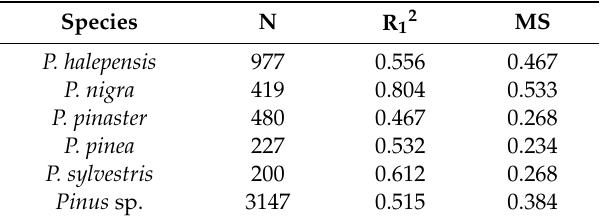
Figure 4. Mean values of NDII-defoliation index synchronization for all Pinus species studied ( left ) and for five Pinus species ( right ) a ff ected by processionary moth for the southeaster Andalusia Pinus forests. Table 1. Number of stands per species with defoliation related to a processionary moth for the time series 1994–2016 and related statistics based on the autoregressive model used in the analysis of the synchrony of the NDII-defoliation